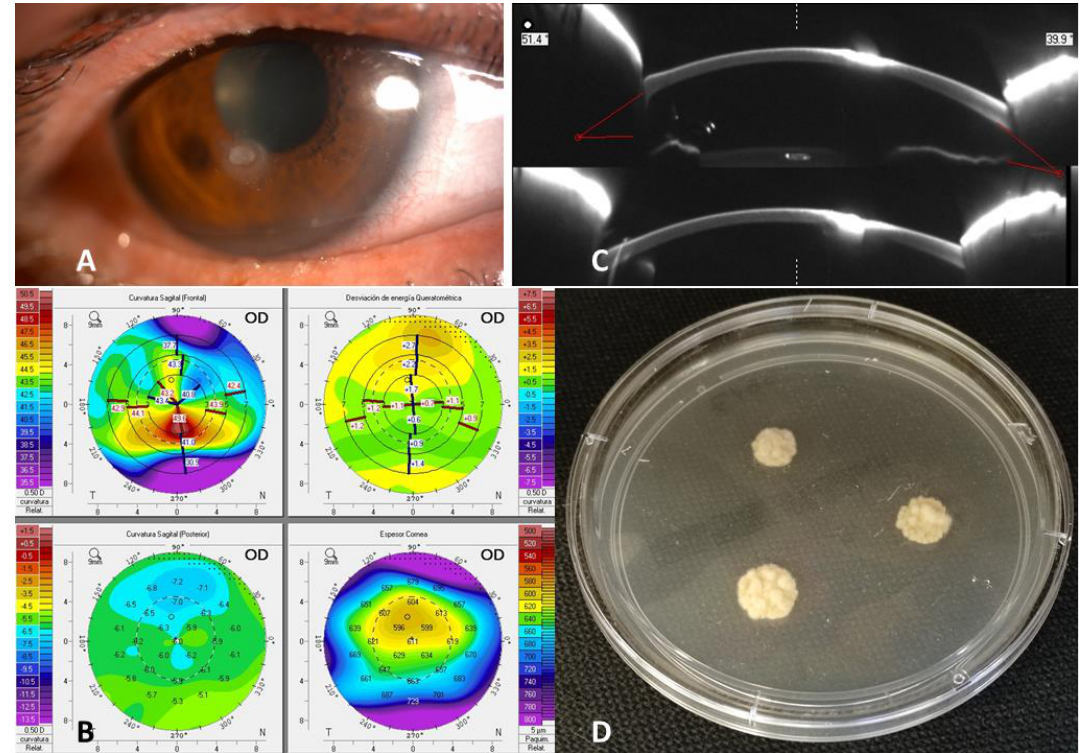
Figure 1. Slit lamp examination showed a dry-looking ulcer with stellate feathery or irregular mar- gins with associated satellite lesions (Figure 1A). Pentacam Scheimpflug imaging was also obtained, showing inferior thinning of the ulcer (Figure 1B) and some calcific precipitates with 50% infiltration of the corneal thickness (Figure 1C). Colonies on Sabouraud-detroxe agar plates (surface) (Figure